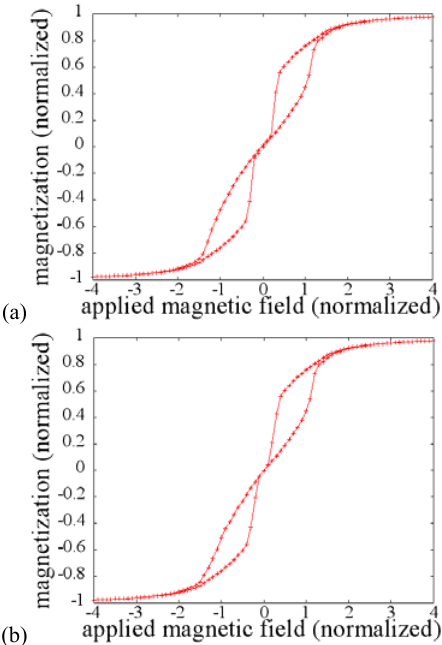
Figure 3: Simulation results with or without convolution execution reduction: (a) execution period p = 1 and (b) p =